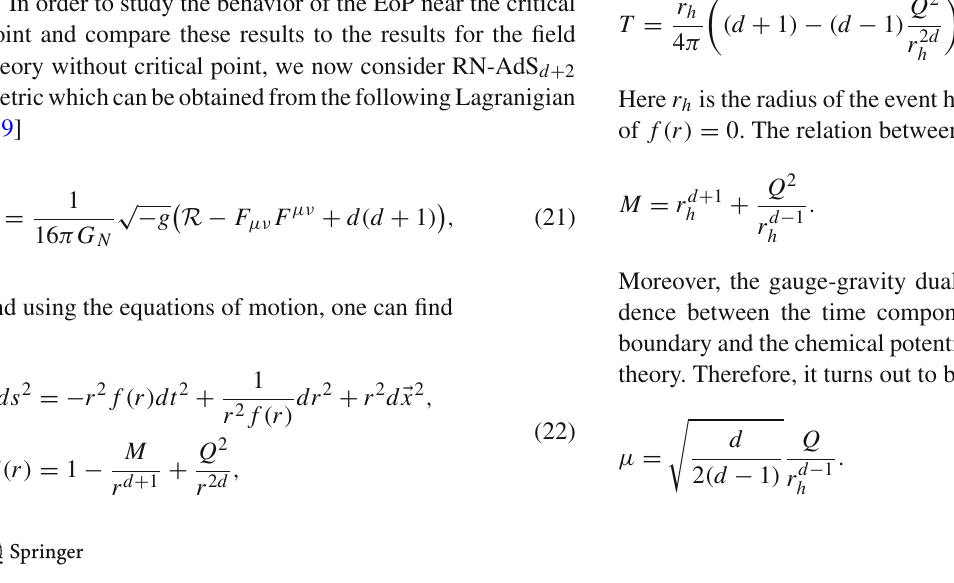
Fig. 3 E p and I / 2 with respect to l for l (cid:3) = 0 . 1 (left) and l (cid:3) = 0 . 2 (right)